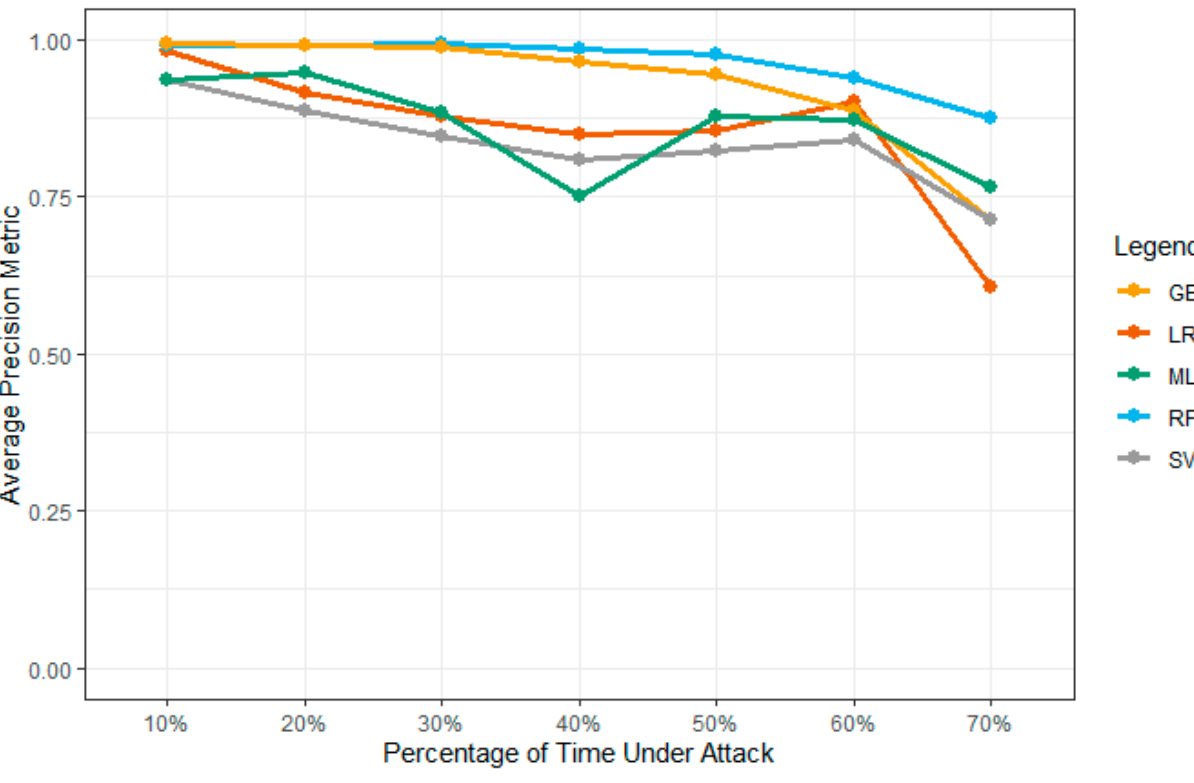
Figure 15. The precision of the models for the proposed system.